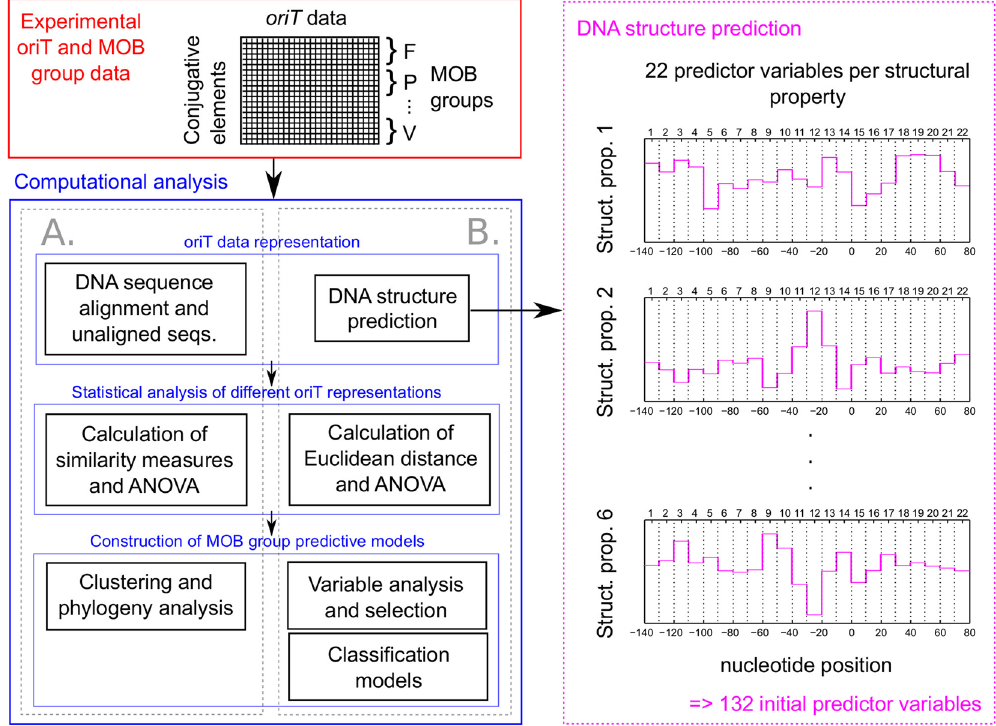
Figure 2. Overview of the performed computational analysis. DNA sequences of oriT regions and their MOB groups were used to compare ( A ) the conventional approach based on analysis of primary sequences with ( B ) our new approach based on DNA structure prediction. oriT regions were ligned up to the nic functional